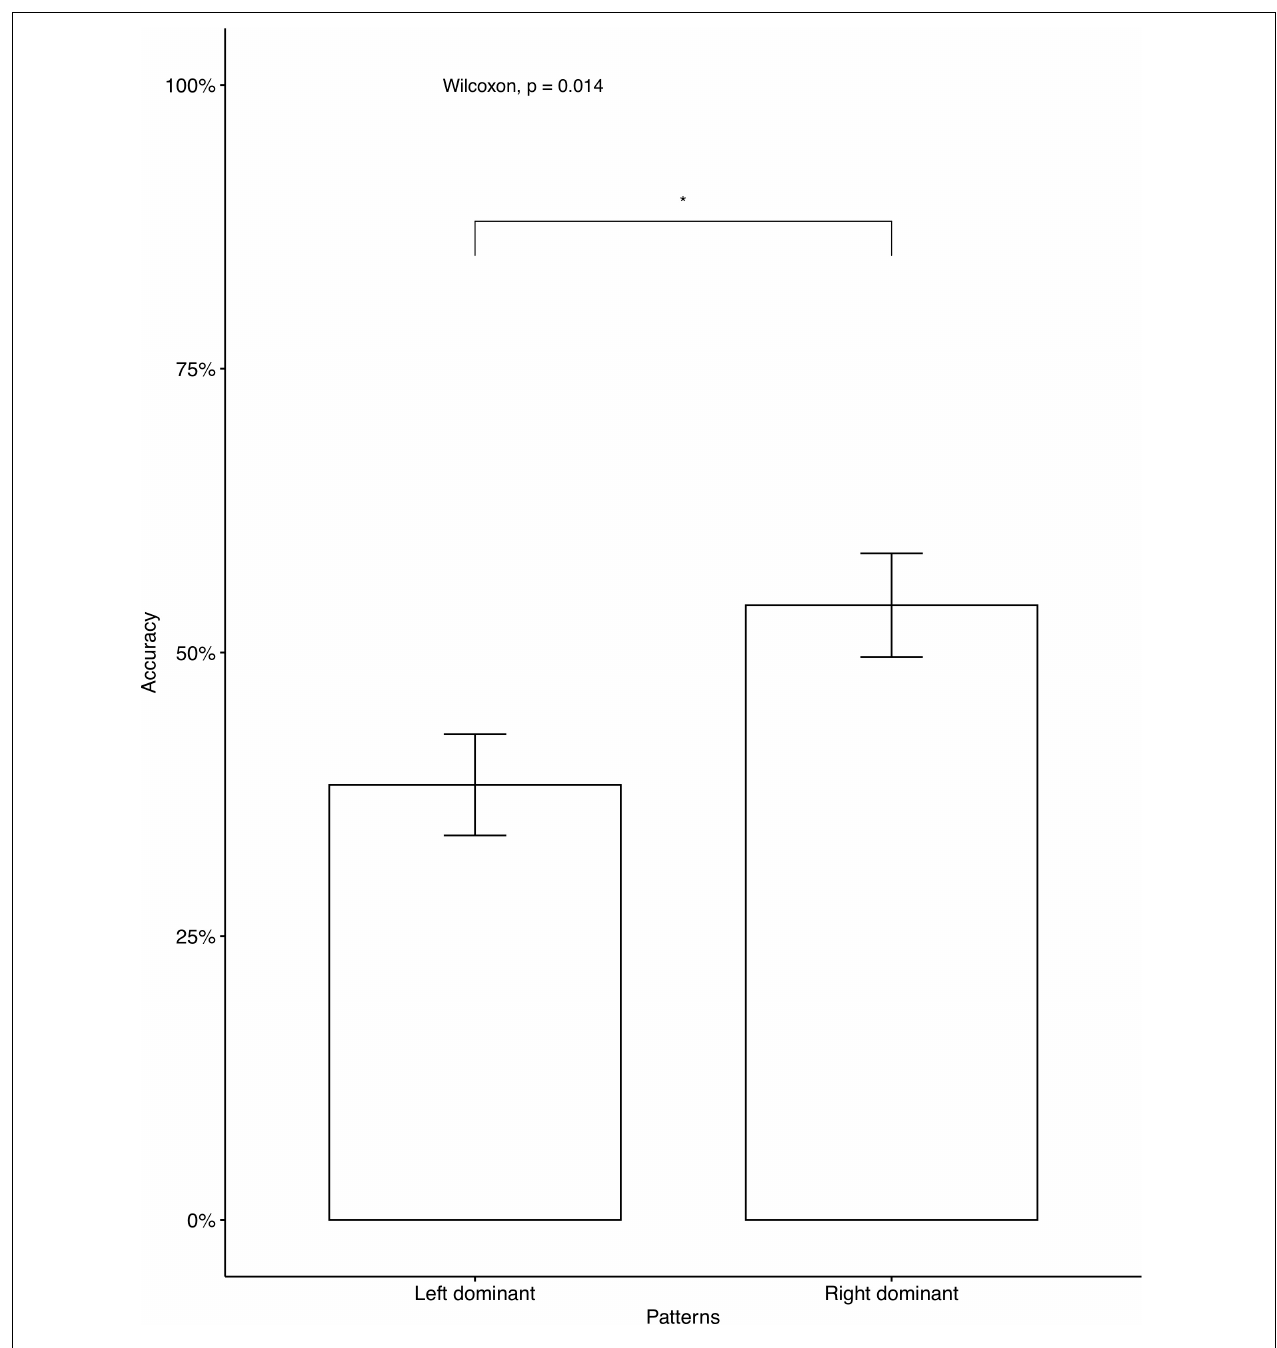
FIGURE 4 | Accuracy on left dominant vs. right dominant patterns in Language BD. The 95% confidence interval is specified for each bar. *indicates significant mean difference, p < 0.05.